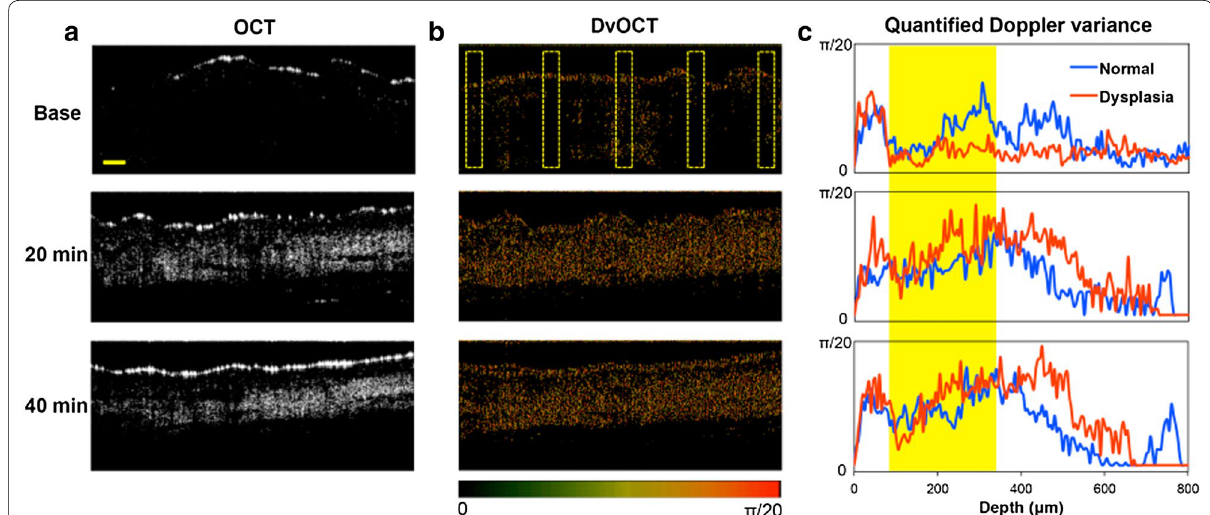
Fig. 7 OCT and DvOCT imaging of dysplastic hamster check pouch with acid‑disassembling Au NCs. Images of DMBA‑applied, early‑stage dysplas‑ tic hamster cheek pouch, obtained by SD‑OCT ( a ) and DvOCT ( b ) after administering acid‑disassembling Au NCs. Scale bar: 100 µm. The images were taken before (base) and 20 and 40 min after administering acid‑disassembling Au NCs. The color‑coded Doppler variance in DvOCT images of early‑stage dysplasia (5 dotted regions) was quantified and compared with that of normal tissue ( c ) (yellow area: epithelial layers)